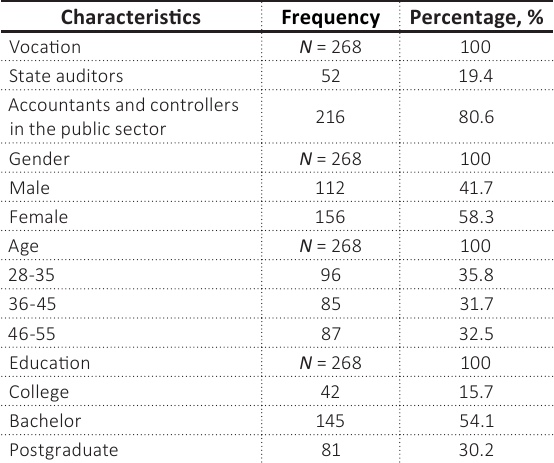
Table 1. Demographic characteristics